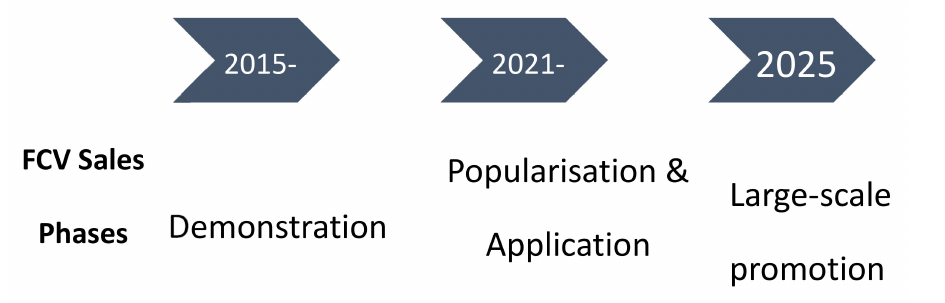
Figure 4. Three phases incentive policy of China for fuel cell